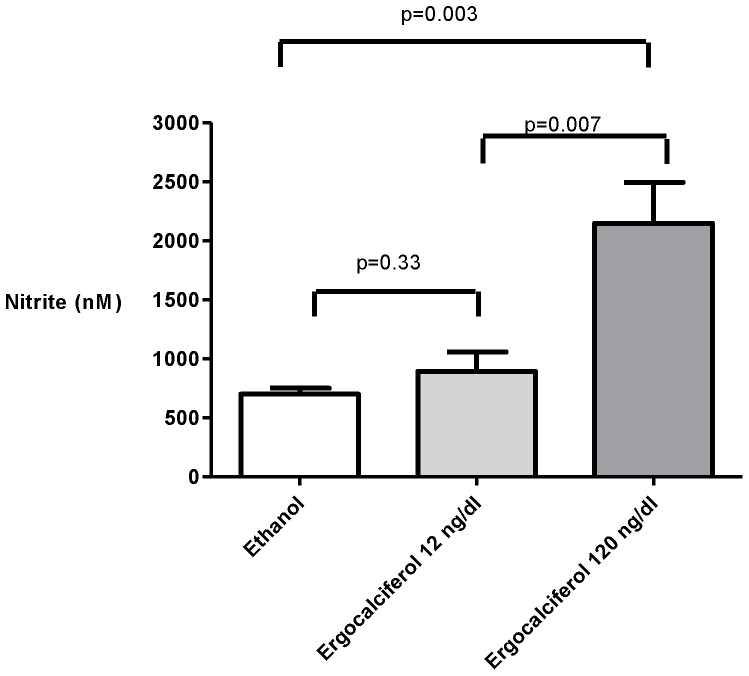
Nitrite levels in supernatants of HAEC.Cultured in low dose (12 ng/dl) and high dose (120 ng/dl) ergocalciferol after 24 h incubation.